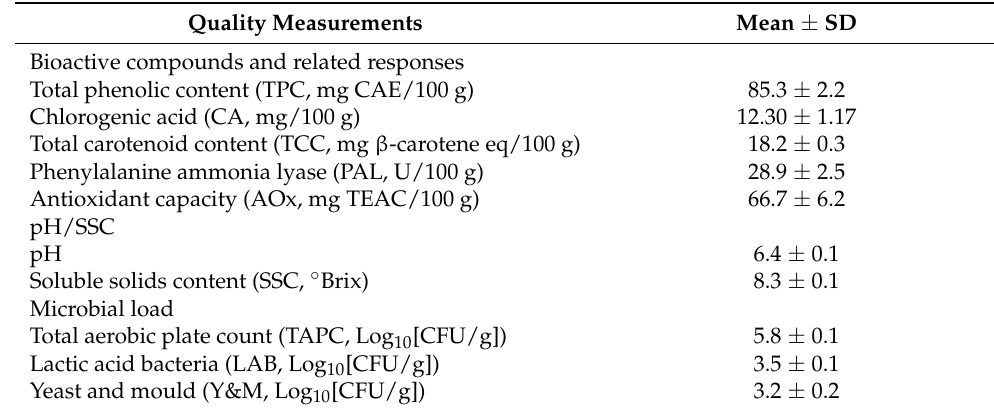
Table 1. Raw material characterisation (fresh cv. Nantes carrots, unprocessed). Quality